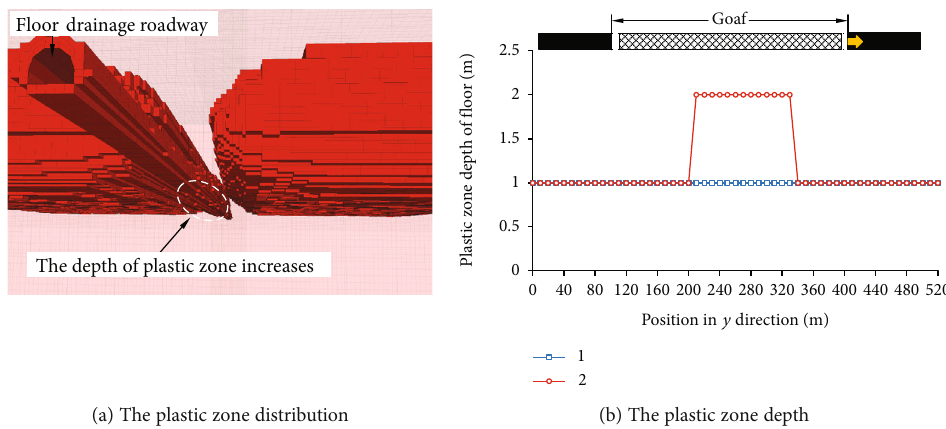
Figure 6: The plastic zone depth under the in fl uence of two working faces arranged at an outer stagger of 15m.